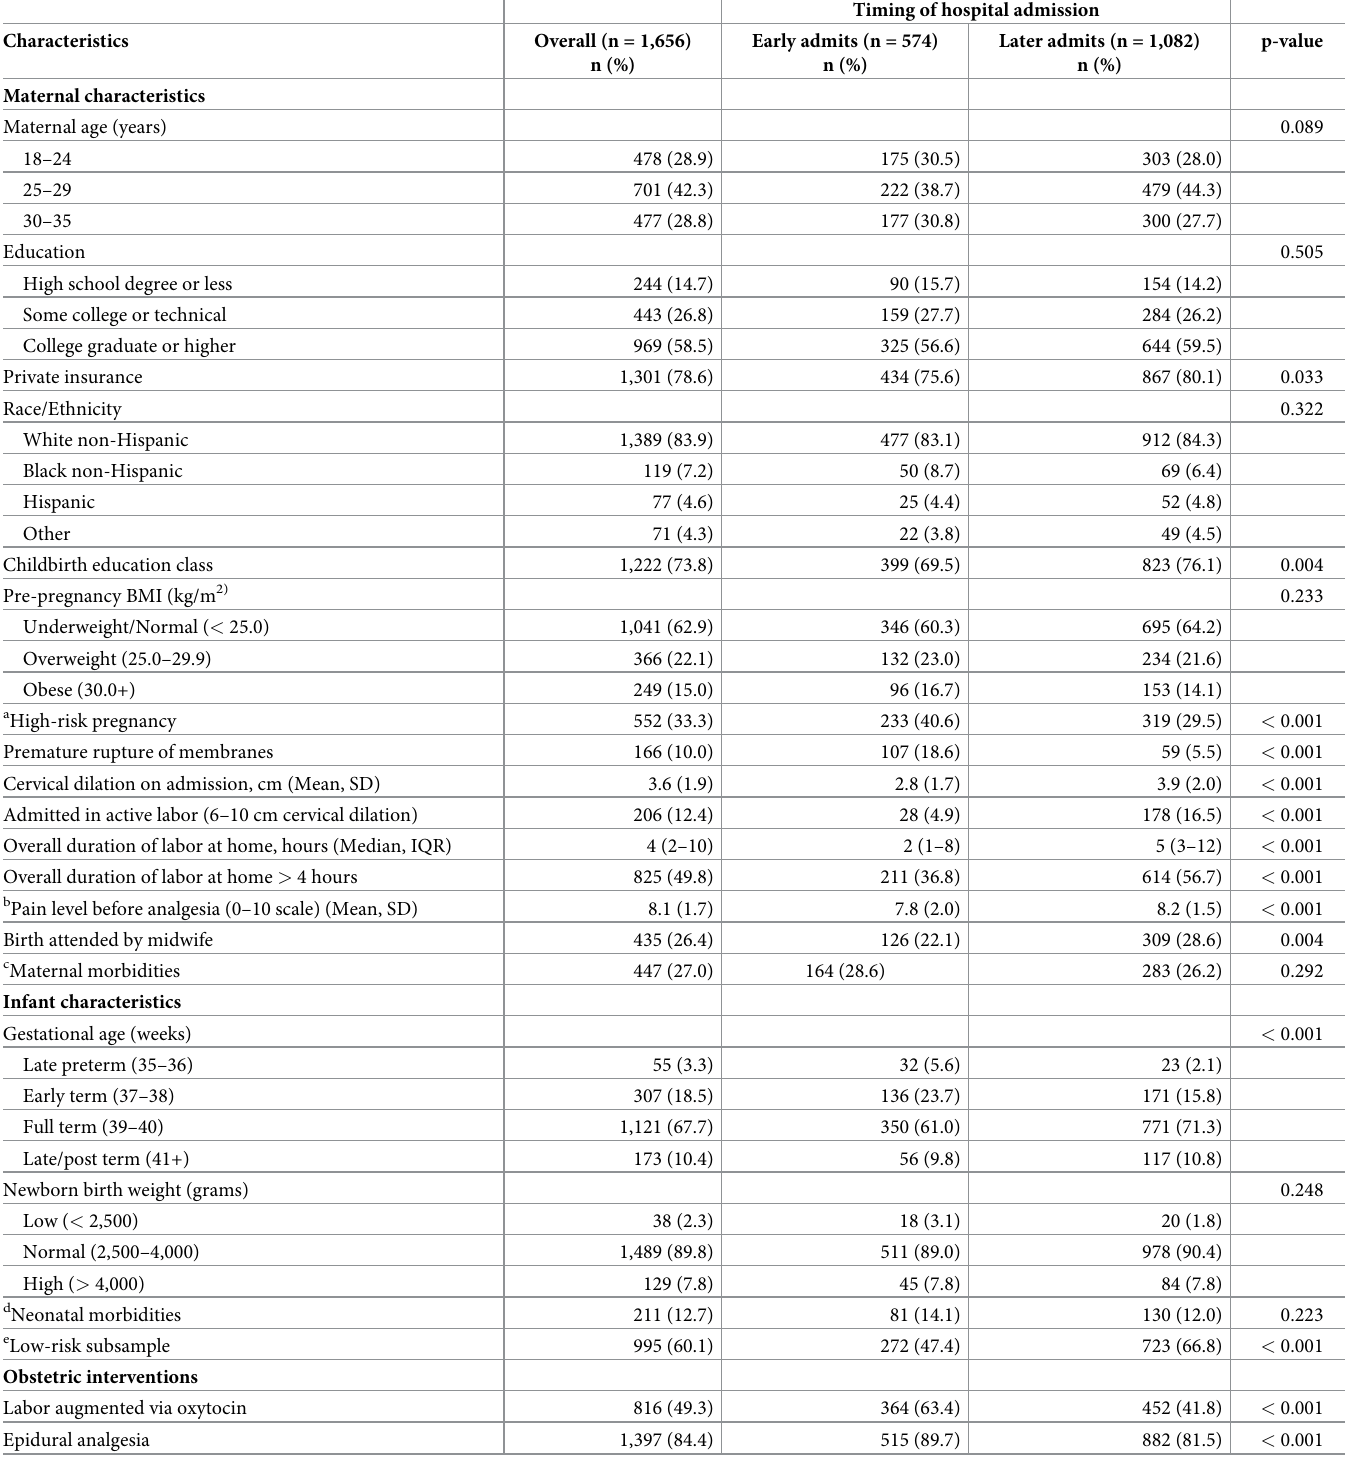
Table 1. Maternal and infant characteristics overall and by timing of hospital